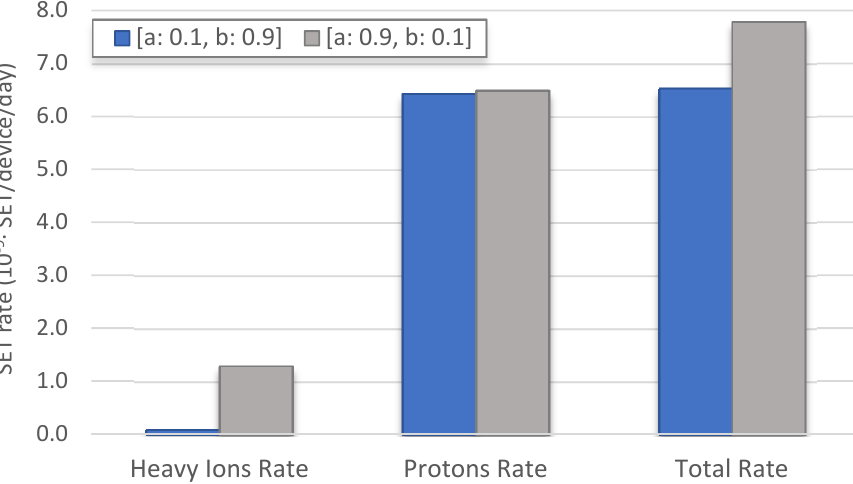
Figure 10. In ‐ orbit SET rate calculated with OMERE [49] based on the proposed SET characterization considering the International Space Station (ISS) orbit, 400 km, 51.64°.